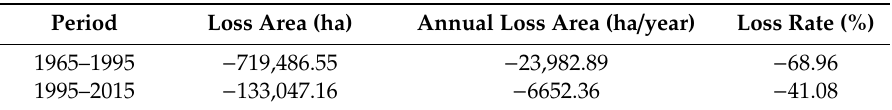
Table 4. Marsh loss rate in different time intervals.